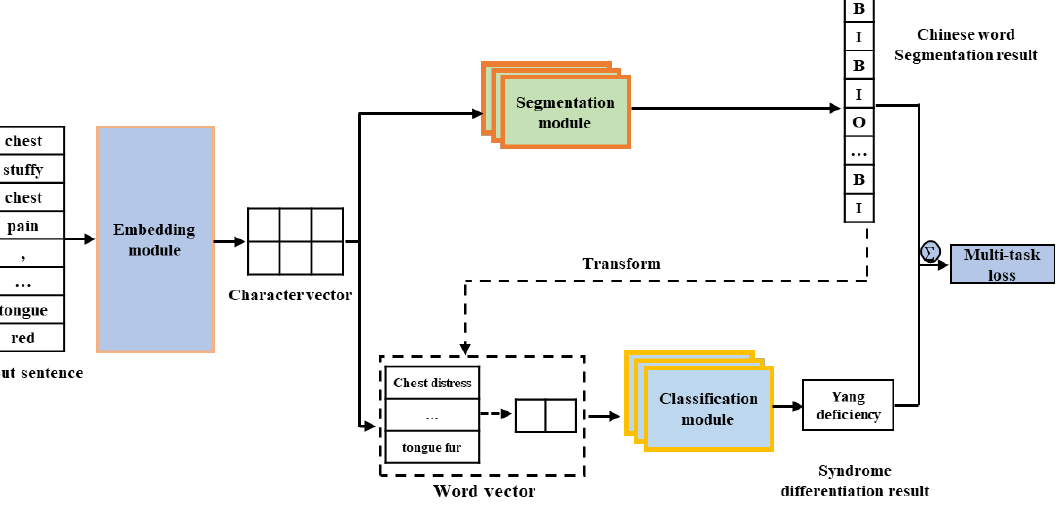
Figure 1. An overview of our framework.